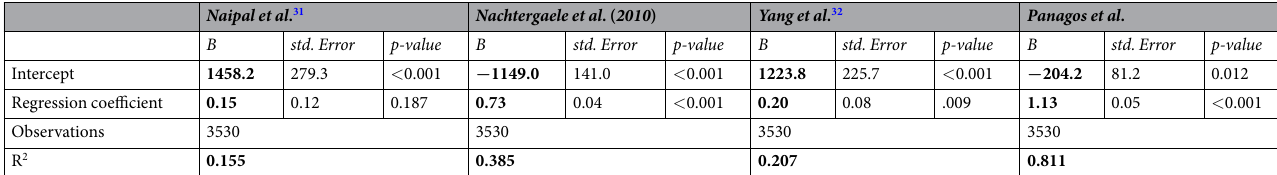
Table 1. Ordinary least squares coefficients (B) of global models for the assessment of rainfall erosivity